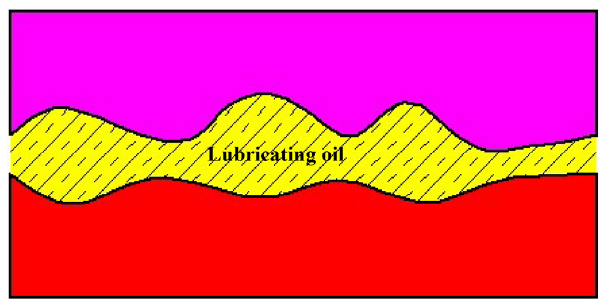
Fig. 5 Illustration of wear mechanism.